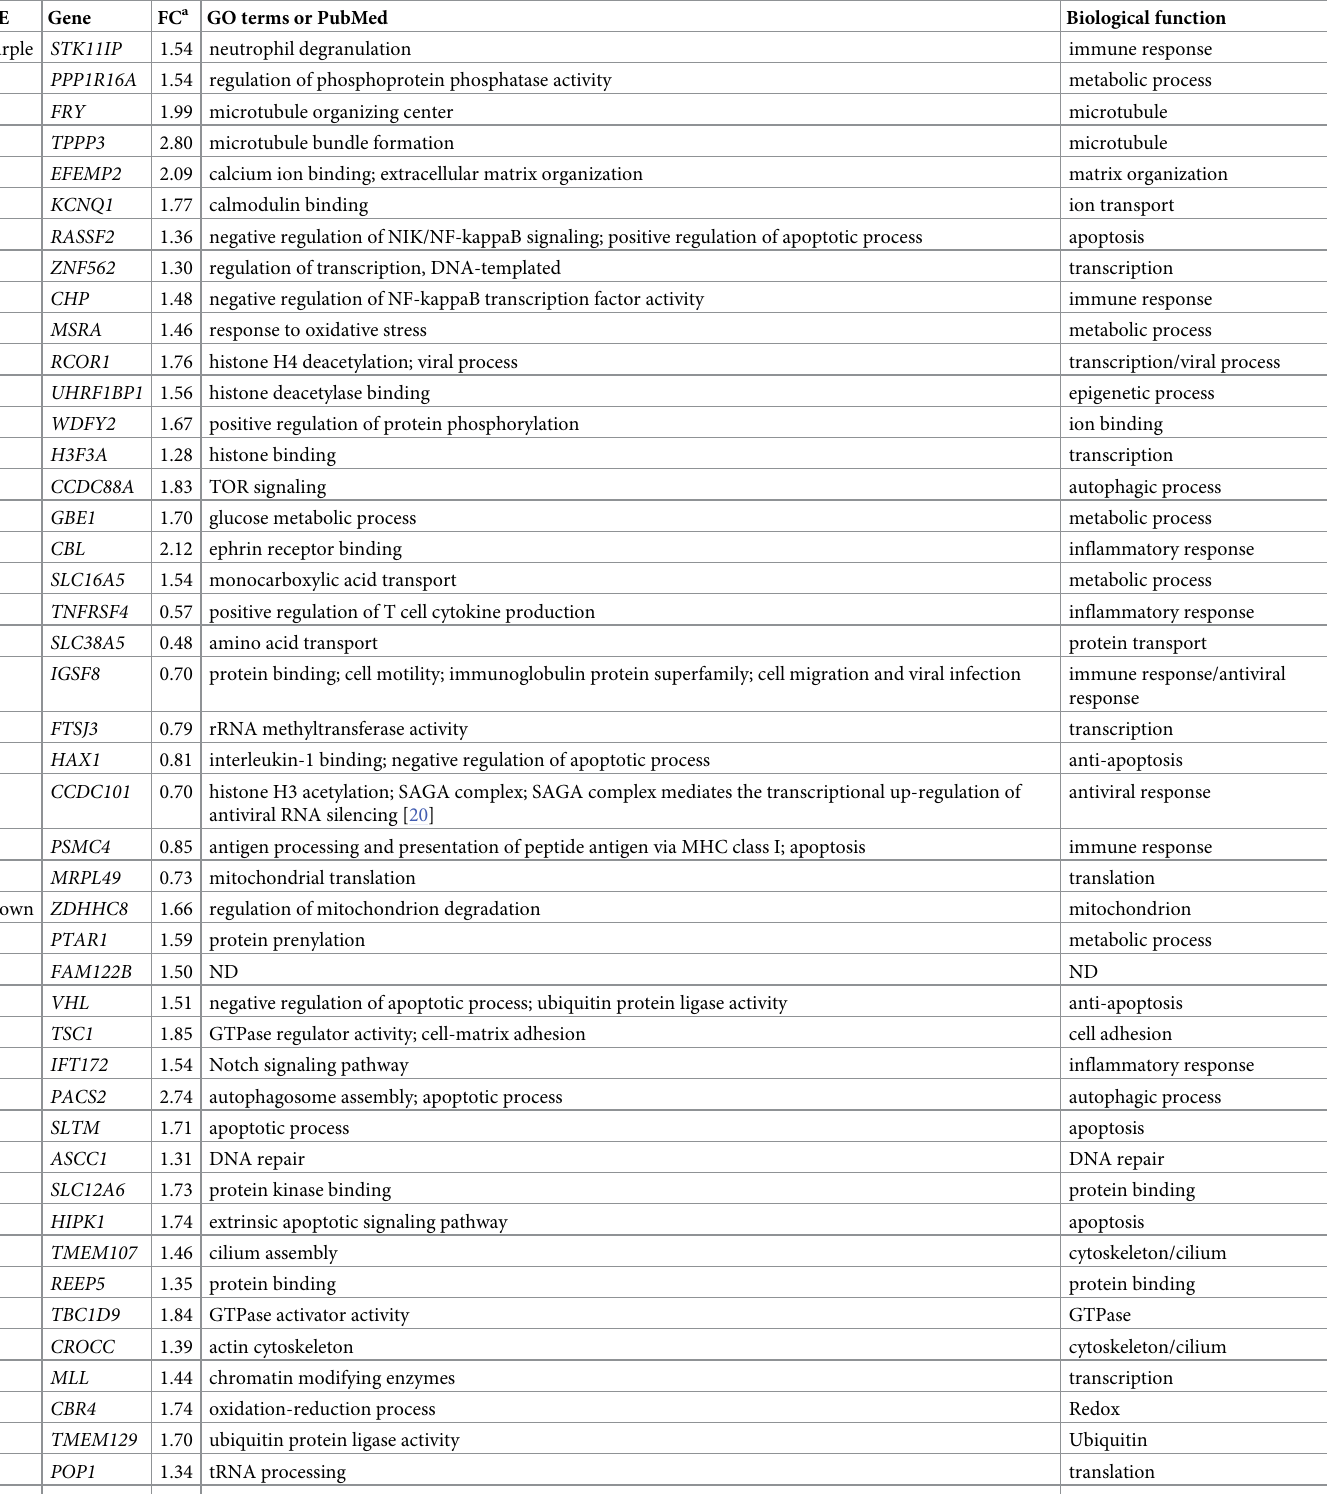
Table 4. Functional description of the HGS-hub genes in modules highly and positively associated with HRV group. ME Gene FC a GO terms or PubMed Biological function Purple